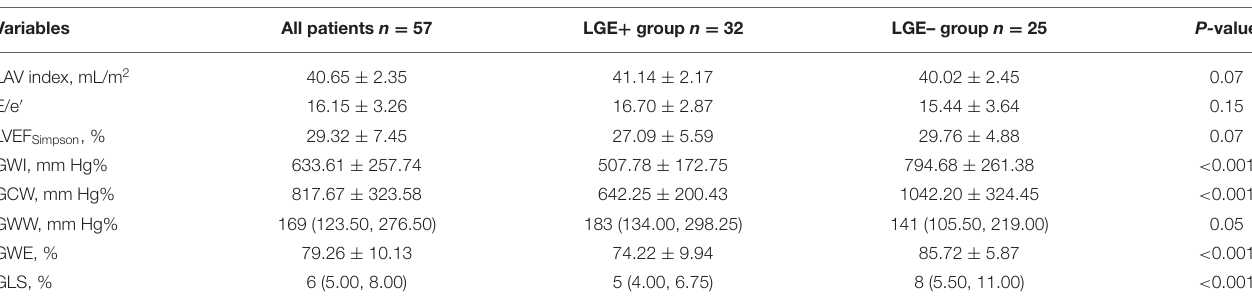
LAV, left atrial volume; E/e’, ratio of the peak mitral flow velocity (E peak) to the average velocity of the mitral annulus (e’); GWI, global work index; GCW, global constructive work; GWW, global wasted work; GWE, global work efficiency; GLS, global longitudinal strain; LVEF Simpson , left ventricular ejection fraction measured using the biplane Simpson method; LGE, late gadolinium enhancement; Data are expressed as mean ± SD, median (IQR).